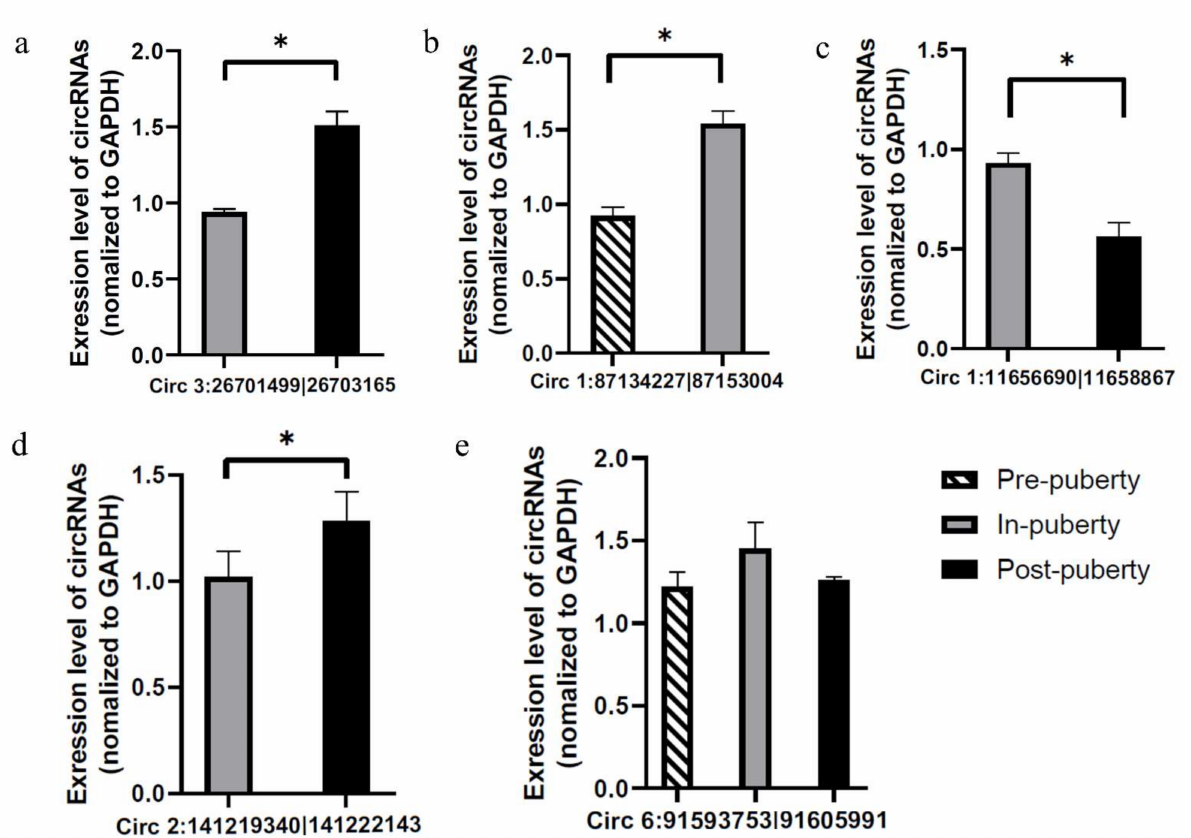
Figure 6. RT-qPCR validation of circRNAs. Five circRNAs were randomly selected for RT-qPCR validation, of which four circRNAs ( a – d ) were differential expression and one circRNA ( e ) was no significant difference. The primer informations were listed in Table S11. * p <